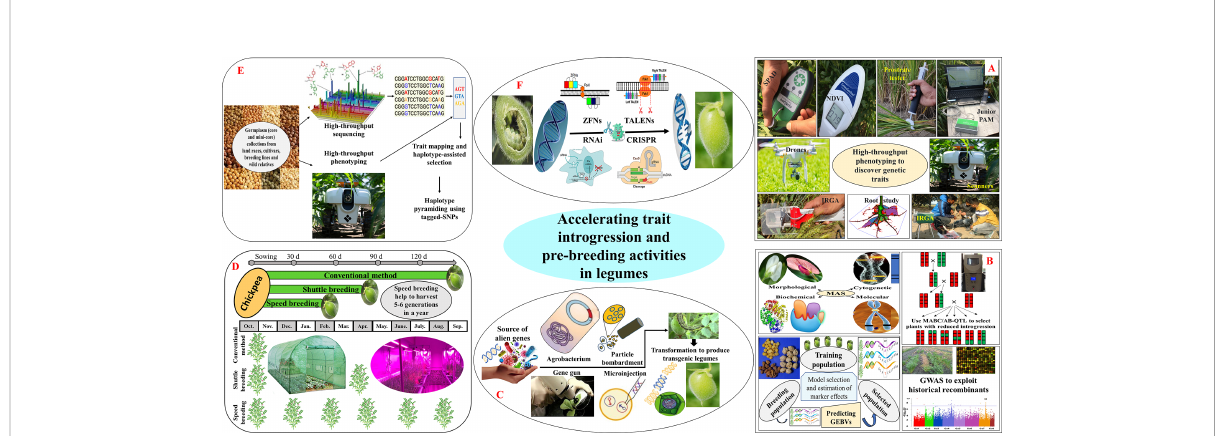
FIGURE 2 Integrated approaches for accelerating trait introgression and achieving higher genetic gain in legumes; (A) high-throughput phenotyping (SPAD-meter, green seeker, prostrate tester, junior PAM, drones, scanners, IRGA, etc.) to take full advantage of large-scale genomic data sets built by next-generation sequencing (NGS) tools; (B) bringing genomic tools like, marker-assisted selection (MAS), marker-assisted backcrossing (MABC), advanced backcross quantitative trait loci mapping (AB-QTL), marker-assisted recurrent selection (MARS), genomic selection (GS), and genome wide association studies (GWAS) to identify and introgress desirable genes or QTLs into legumes with high ef fi cacy; (C) biotechnology (gene gun, particle bombardment, microinjection, and Agrobacterium ) mediated transformation of alien genes to produce pest, disease and herbicide resilient transgenic crops; (D) dialling physiology of plants with protracted photoperiod, elevated temperature and CO 2 coupled with immature seed harvest to accelerate generation advancement; (E) developing tailor-made crop varieties by using haplotype-based breeding; (F) targeted genome editing using meganucleases, zinc fi nger nucleases (ZFNs), transcription activator-like effector nucleases (TALENs), and clustered Regularly Interspaced Short Palindromic Repeats (CRISPRs) to produce non-transgenic, genome edited